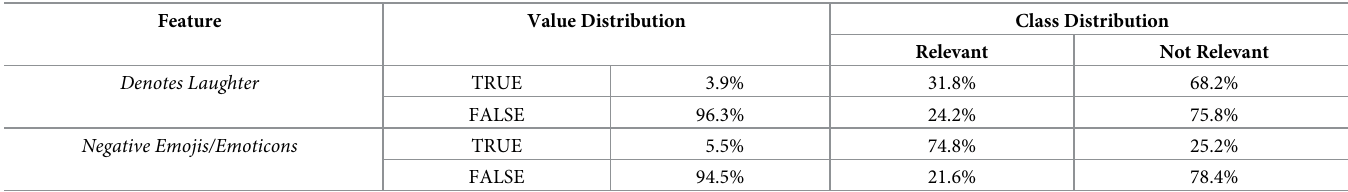
Table 5. Distribution of some constructed features and classes across the dataset.